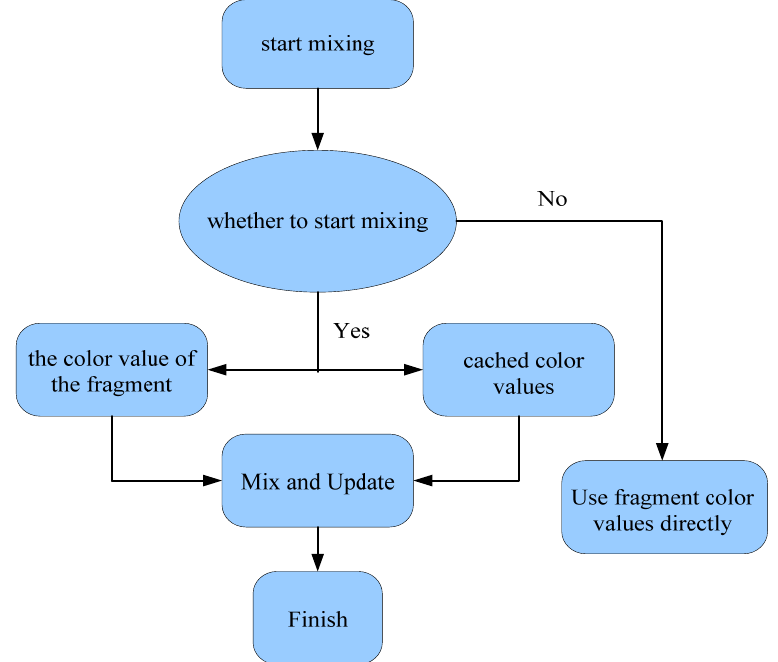
Figure 3. Flowchart of the blending operation.